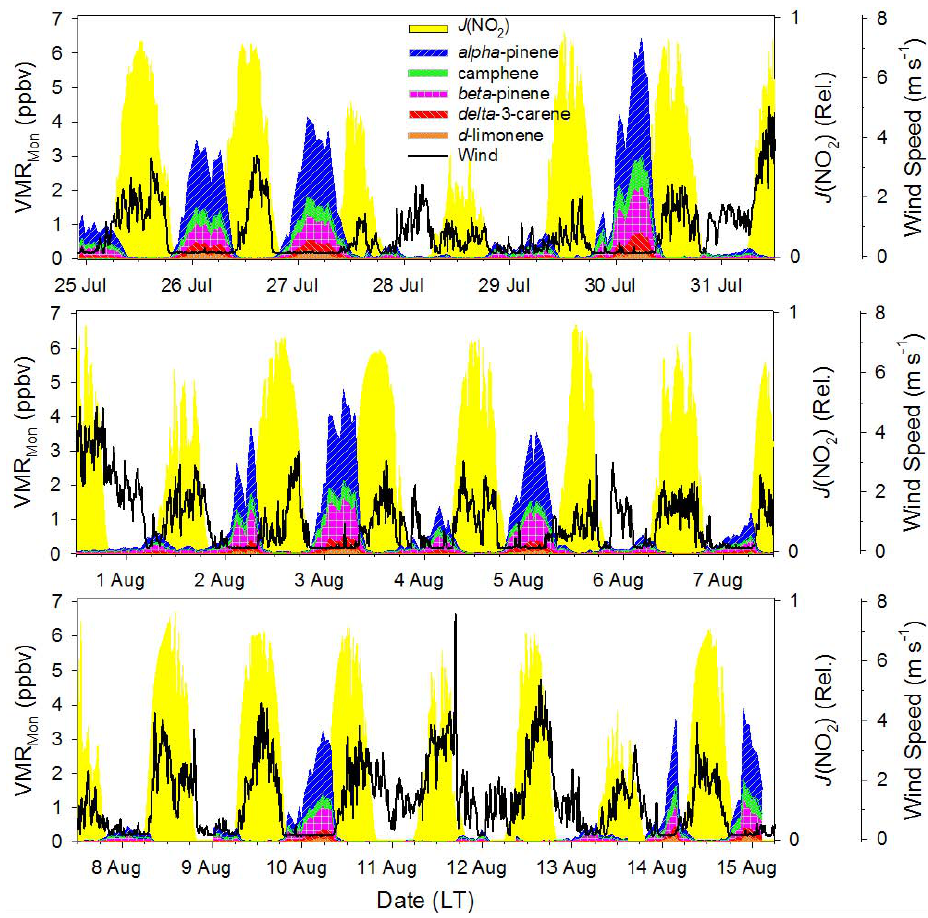
Fig. 5. Time series of monoterpenes, J (NO 2 ) (10min averaged) and wind speed (10min averaged) measured at THF from 24 July, 22:00 LT to 15 August, 06:00 LT. Values of J (NO 2 ) relative to the summertime maximum delineate daytime and nighttime periods. Mixing ratios below the LOD were set to 0.5 ×